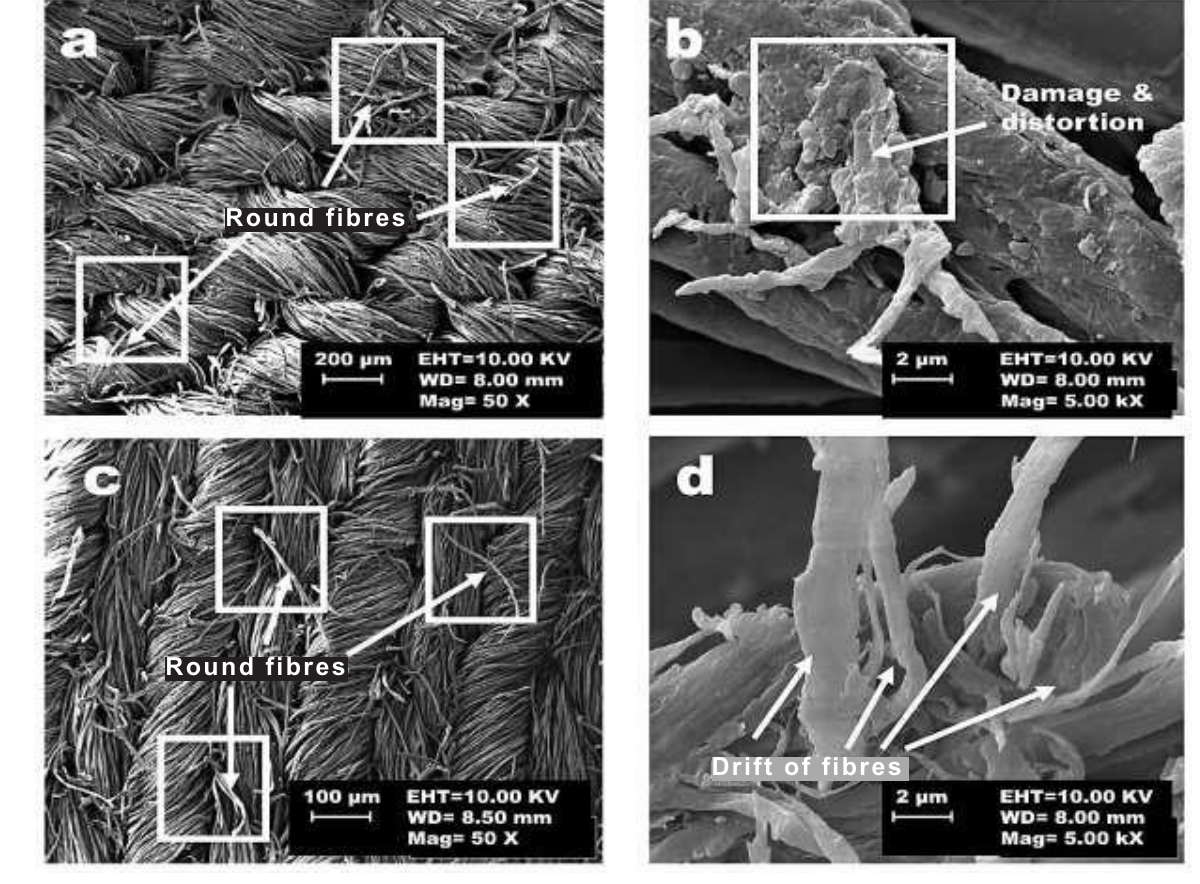
Fig. 2. SEM images: (a) (X 50) weft round fibres, (b) (X 5.00 K) weft rough and distorted fibres, (c) (X 50) warp round fibres, (d) (X 5.00 K) warp rough and distorted fibres.